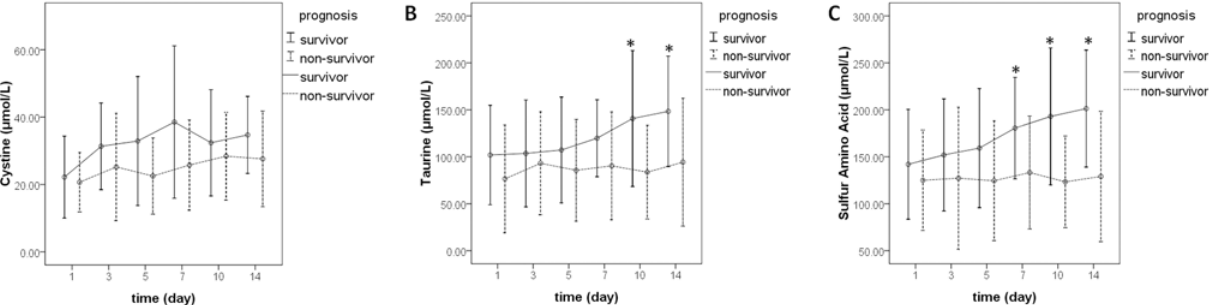
Fig 3. The dynamic changes in cystine (A), taurine (B), and sulfur-containing amino acid (C) levels between survivors and non-survivors on days 1, 3, 5, 7, 10, and 14. * P < 0.05.